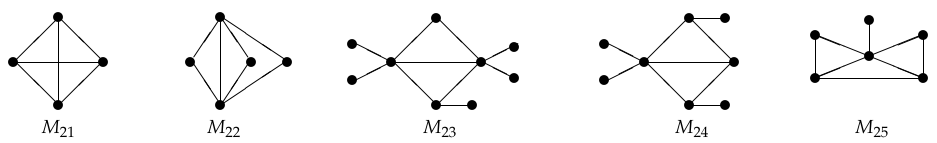
Figure 10. 4-cutwidth critical graphs without a central vertex and central